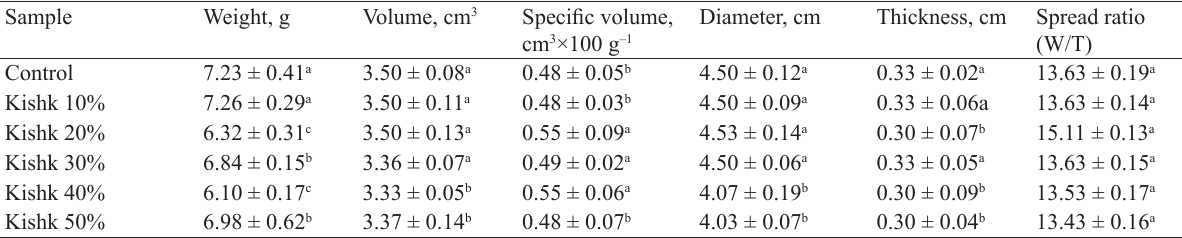
Table 4 Physical characteristics of biscuit fortified with Egyptian kishk Sample